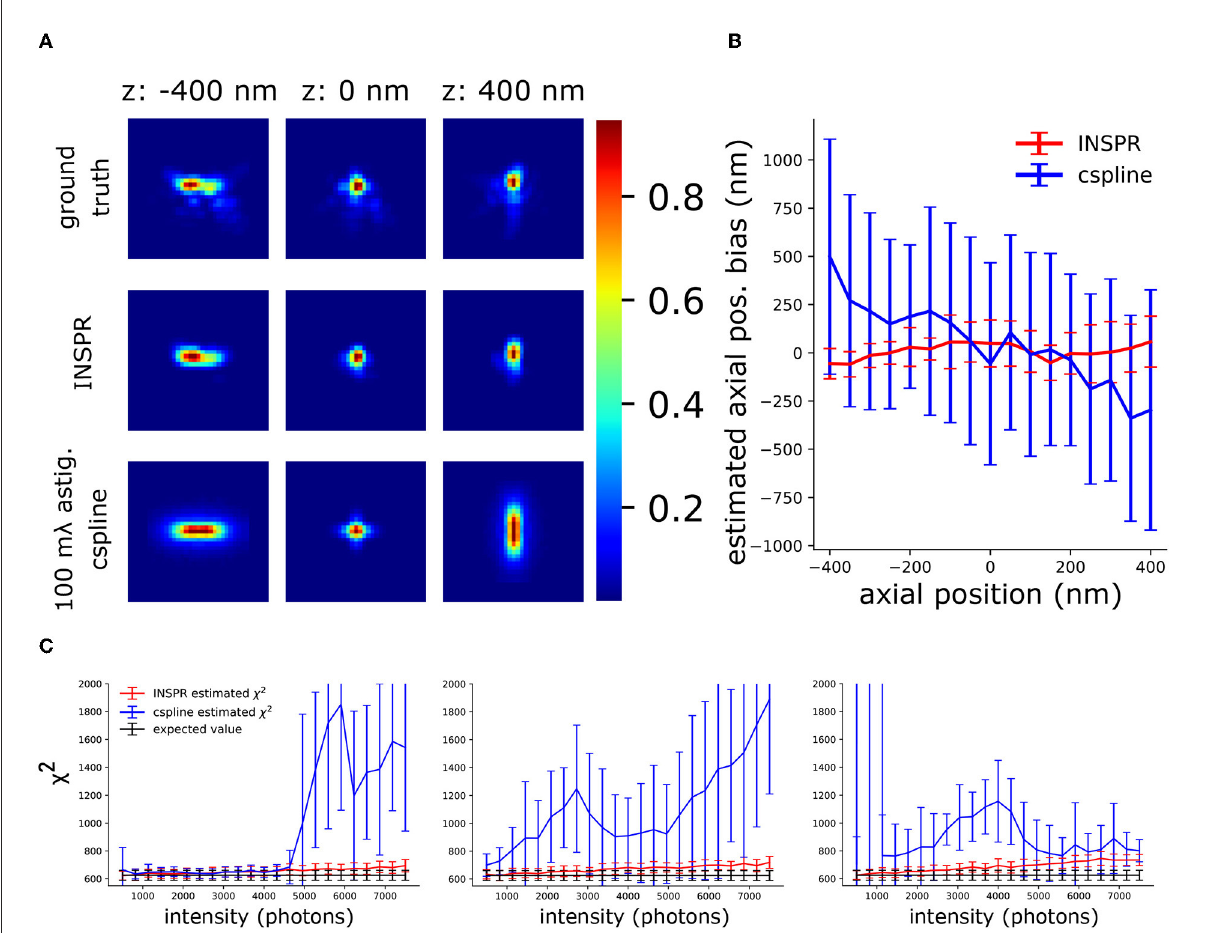
FIGURE6 Investigation of the synergy between INSPR and AO-SOLEIL. (A) PSFs with AO correction. Ground truth: The PSF simulated using the true Zernike aberrations. INSPR: PSFs calibrated from the raw SMLM data. 100 m λ astig. cspline: cubic spline PSF model calibrated by z-stack PSFs data without sample-induced aberration. (B) The axial position bias ( z true − z estimated ). (C) χ 2 of PSF models estimated using INSPR and cspline